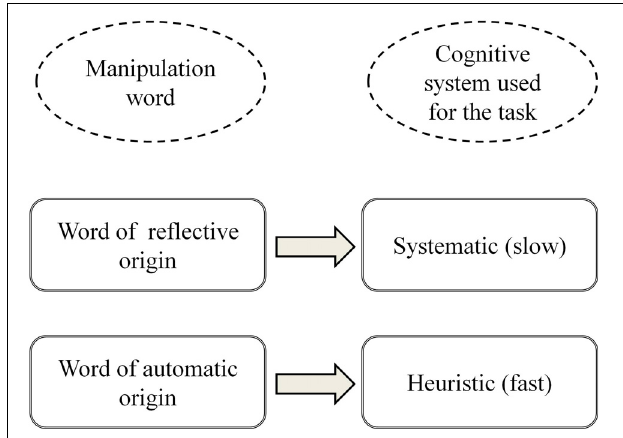
FIGURE 1 | The model of relation between the origin of emotional charge in words and the level of cognitive processing used in the ambiguous task (Imbir, 2016a).